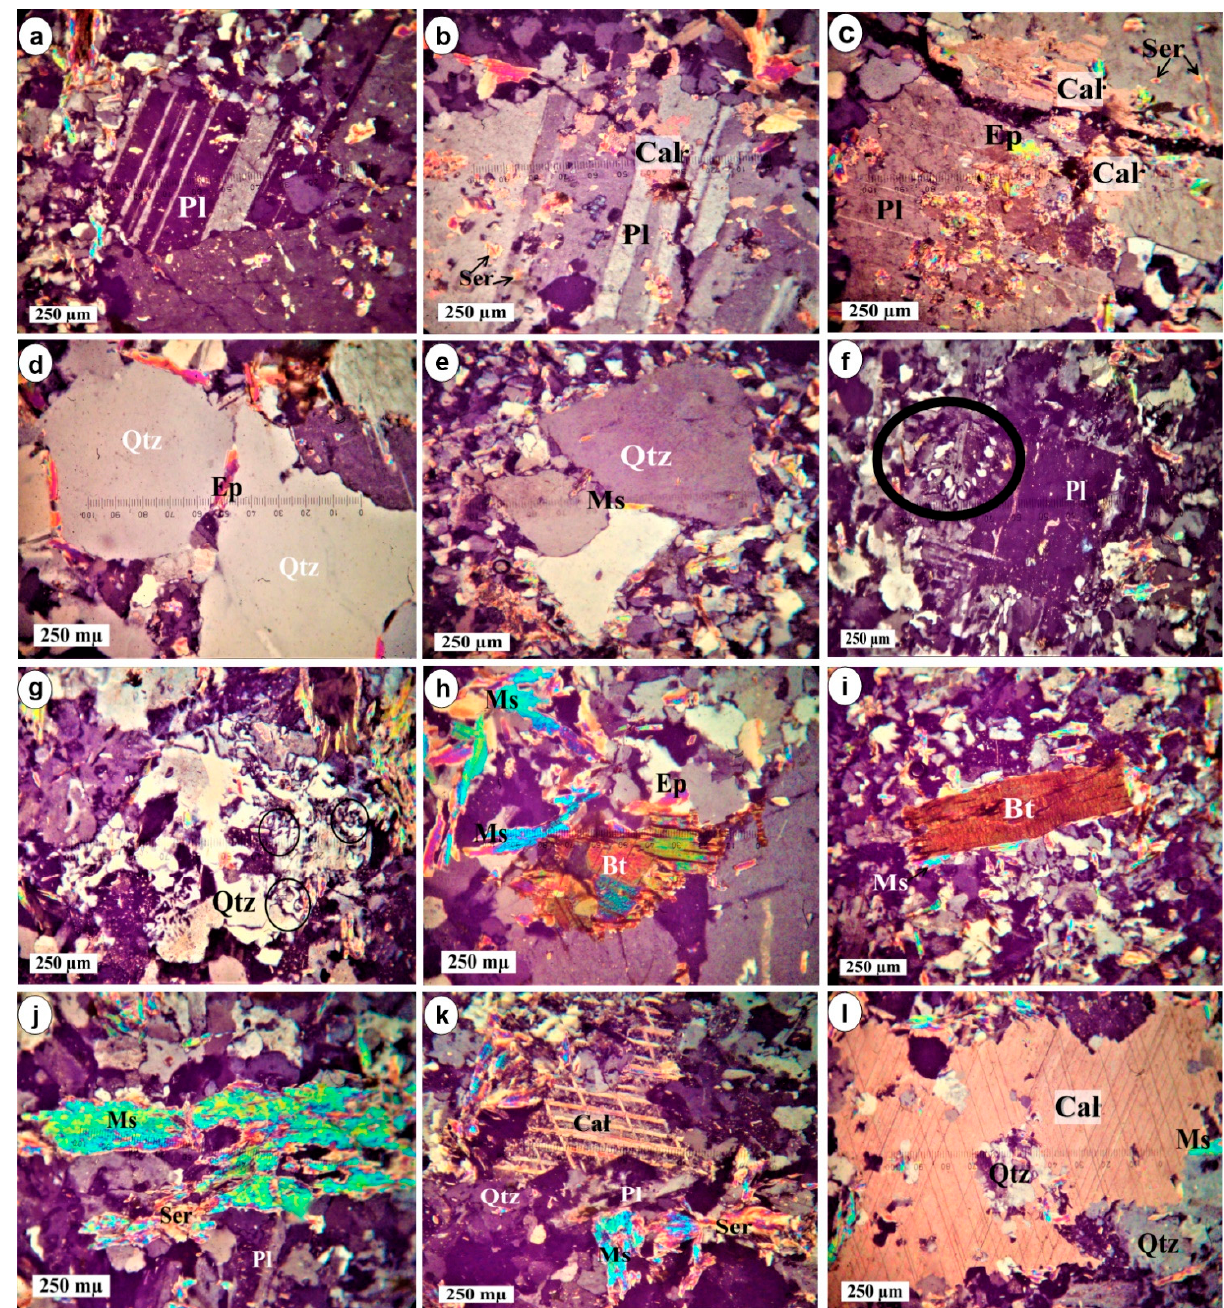
Figure 4. Photomicrographs showing the petrographic features of the Abu- Dabbab plagio-granites showing: ( a ) Subhedral plagioclase (Pl) altered to sericite (Ser). ( b ) Deformed plagioclase (Pl) crystals and poikilitic texture showing well developed crystals of sericite (Ser) and calcite (Cal). ( c ) Highly altered to saussurite (sericitization, carbonation, and epidotization). ( d , e ) Well undulose extinction of quartz (Qtz) exhibiting polygonal and porphyritic texture. ( f ) Myrmekitic texture resulting from intergrowing of quartz (Qtz) with sodic feldspar in plagio ‐ granite (Pl). ( g ) Micrographic texture. ( h , i ) Large biotite crystal (Bt) altered to epidote (Ep) and muscovite (Ms). ( j ) Muscovite flakes (Ms) slightly altered to sericite (Ser). ( k , l ) Well ‐ developed calcite (Cal) crystals exhibit good three sets of cleavage.